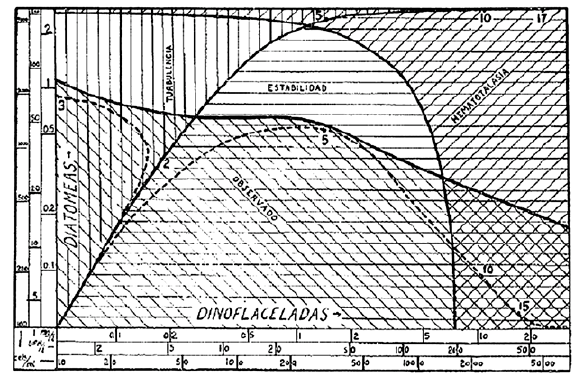
Fig. 2. – Diagram of the possibilities that can occur in a mixed population of diatoms (“Diatomeas”, ordinate) and dinoflagellates (“Dinoflageladas”, abscissa). The different stripes indicate states corresponding to stability (“Estabilidad”), turbulence (“Turbulen- cia”), red tide (“Hematotalasia”) and actually observed situations (“Observado”). The combinations of stripes in relation to the com- position of the mixed populations expresses the multiple possibili- ties that exist (From Margalef 1956e: Fig.